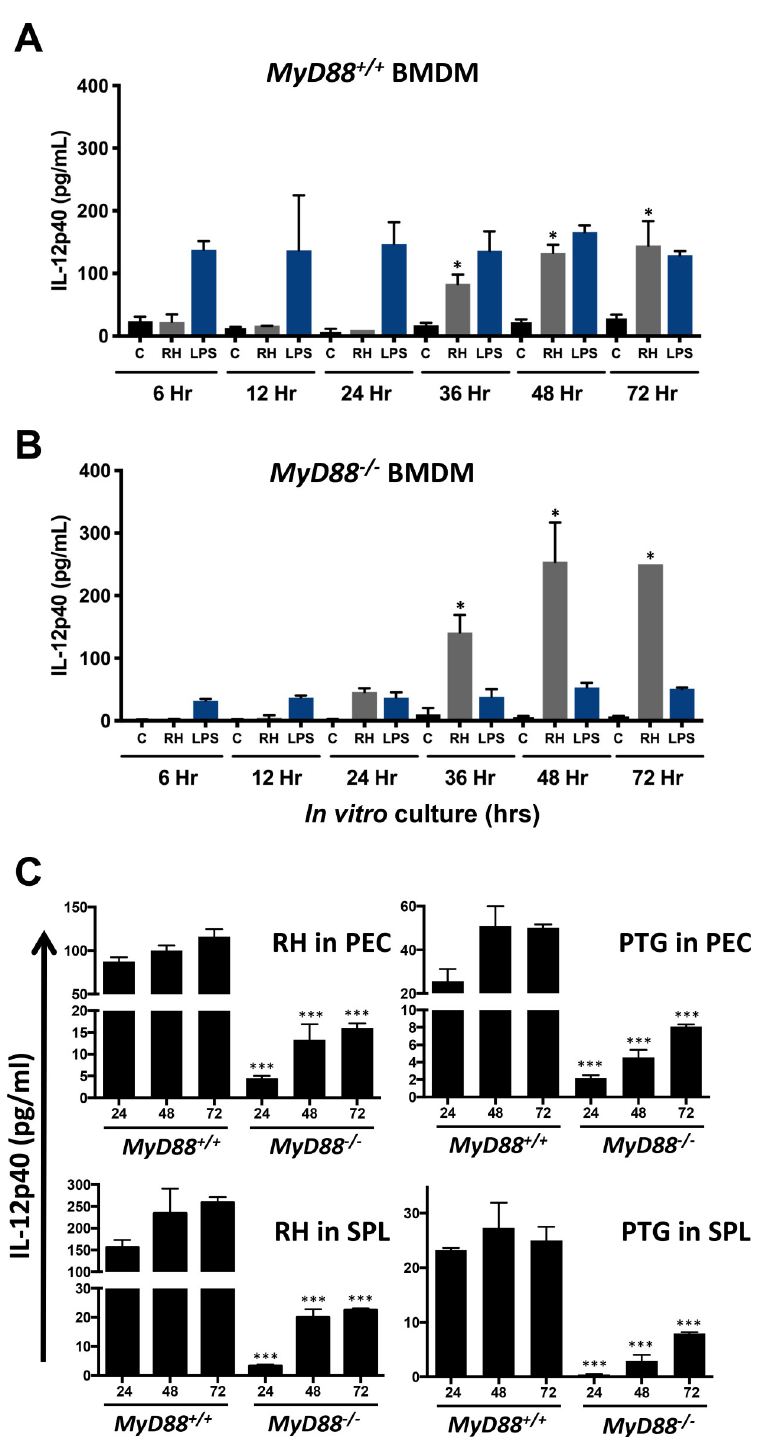
Fig 1. Toxoplasma gondii triggers production of MyD88-independent IL-12 during in vivo and in vitro infection. Bone marrow-derived macrophages (BMDM) from wild-type ( A , MyD88 +/+ ) and MyD88 knockout ( B , MyD88 -/- ) mice were cultured in medium (C), infected with RH strain tachyzoites (1:1 ratio of parasite to cells) or stimulated with LPS (100 ng/ml). At the indicated time points, supernatants were collected for cytokine ELISA. ( C ) MyD88 +/+ and MyD88 -/- mice (n = 2 per group) were infected by intraperitoneal inoculation with 10 3 RH or PTG strain tachyzoites. Four days later, peritoneal exudate cells (PEC) and splenocytes (SPL) were isolated and cultured with no further